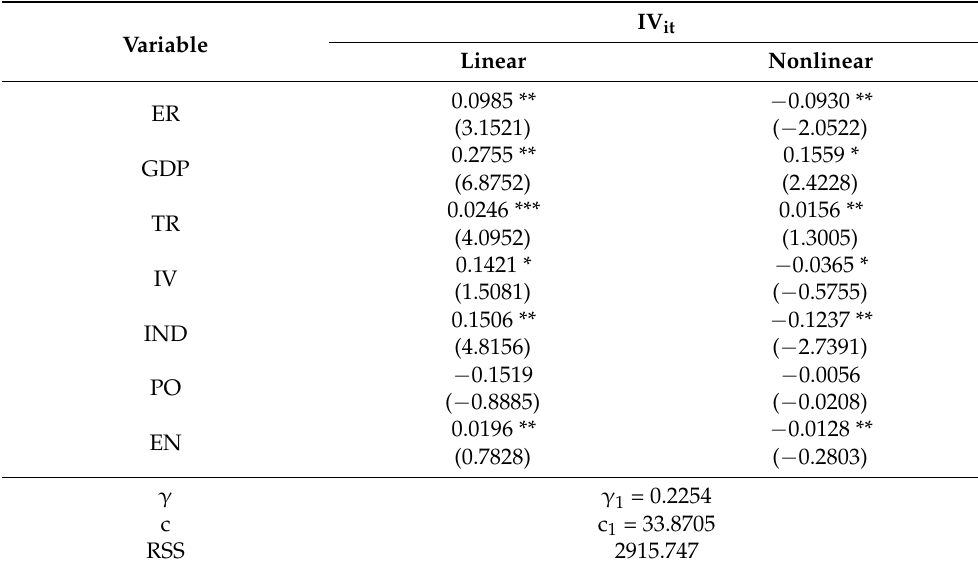
Table 7. PSTR results with technical innovation as the threshold